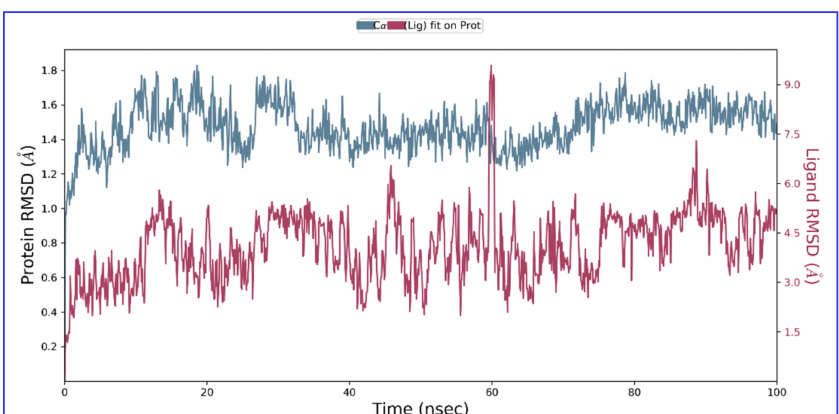
Figure 6. The RMSD (in Å) of Fts-Z protein (PDB ID- 2VXY) with ADMA (ligand) compound during 100 ns MD trajectory. The fluctuations of both the ligand and the receptor were in an acceptable range. Fts-Z protein (in green) fluctuation was within 2 Å, achieving stability towards the end of the simulation, and that of ligand (in maroon) with respect to protein and its binding pocket was also not fluctuating significantly showing a stabler